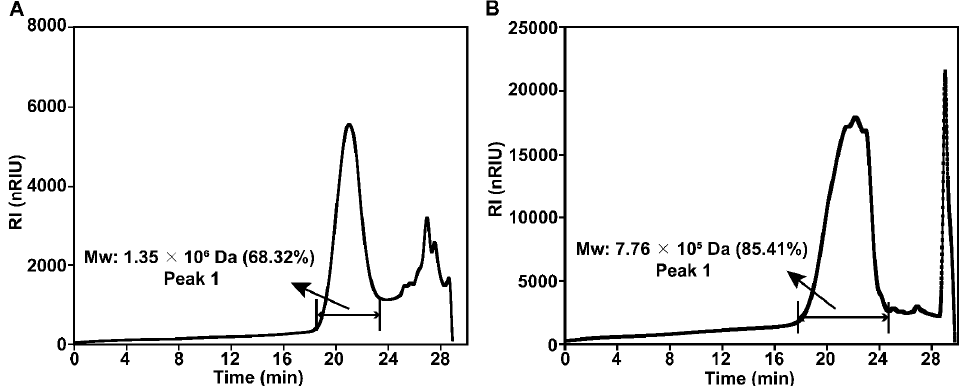
Figure 2. HPGPC pro fi les of MPS ( A ) and Se-MPS ( B ). Figure 2. HPGPC profiles of MPS ( A ) and Se-MPS ( B ).